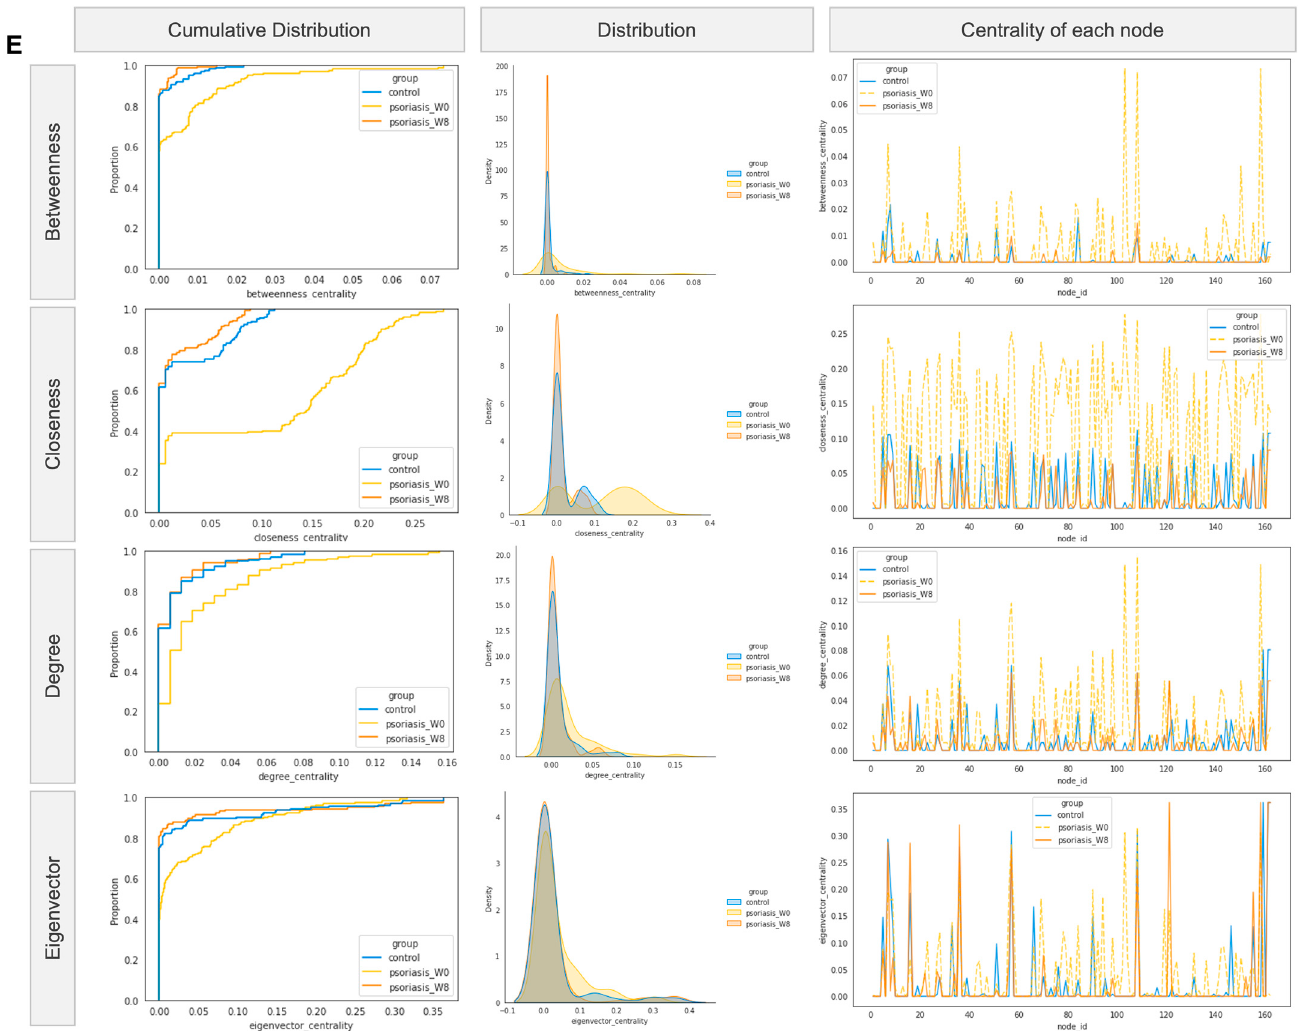
Figure 5. Co-occurrence/co-exclusion network. ( A , B , C ) Co-occurrence network diagram of control and psoriasis group. ( D ) Venn diagram of top 10 hub nodes across networks. ( E ) Empirical cumulative distribution function (eCDF) ( left ) and kernel density distribution ( middle ) of betweenness, closeness, degree, and eigenvector centrality measures and centrality of each node ( right ).